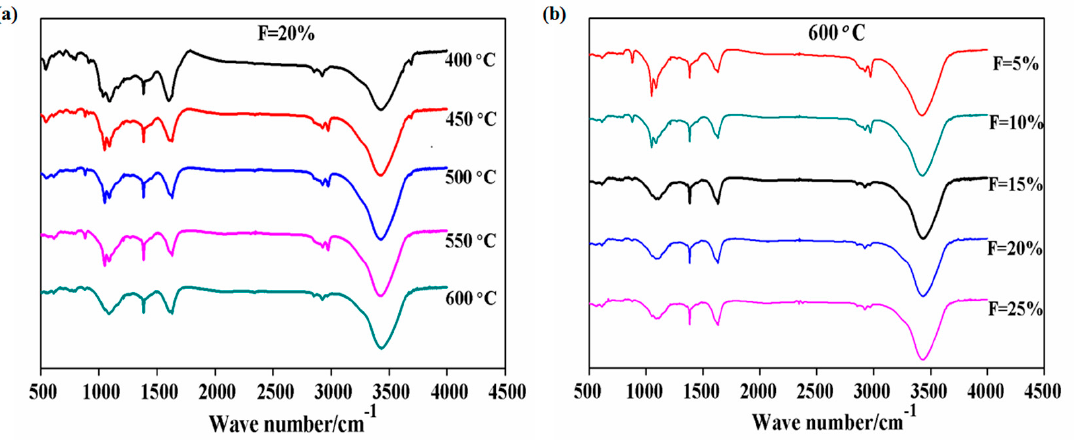
Figure 6. The FT-IR spectra of the co-pyrolysis product char. ( a ) different terminal temperatures, ( b ) different PVC additions.